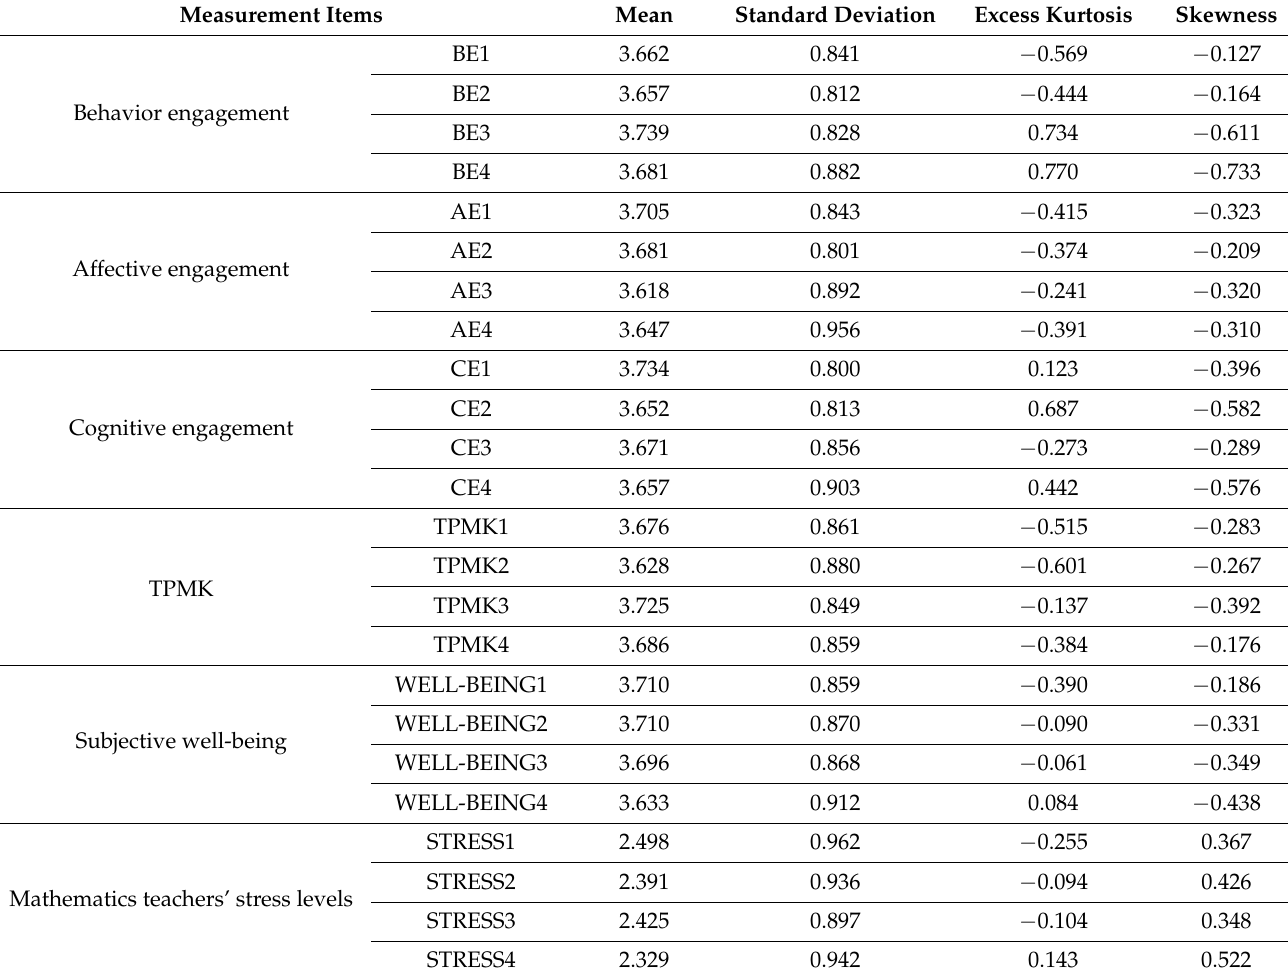
Table 2. Mean, SD, skewness, and kurtosis.